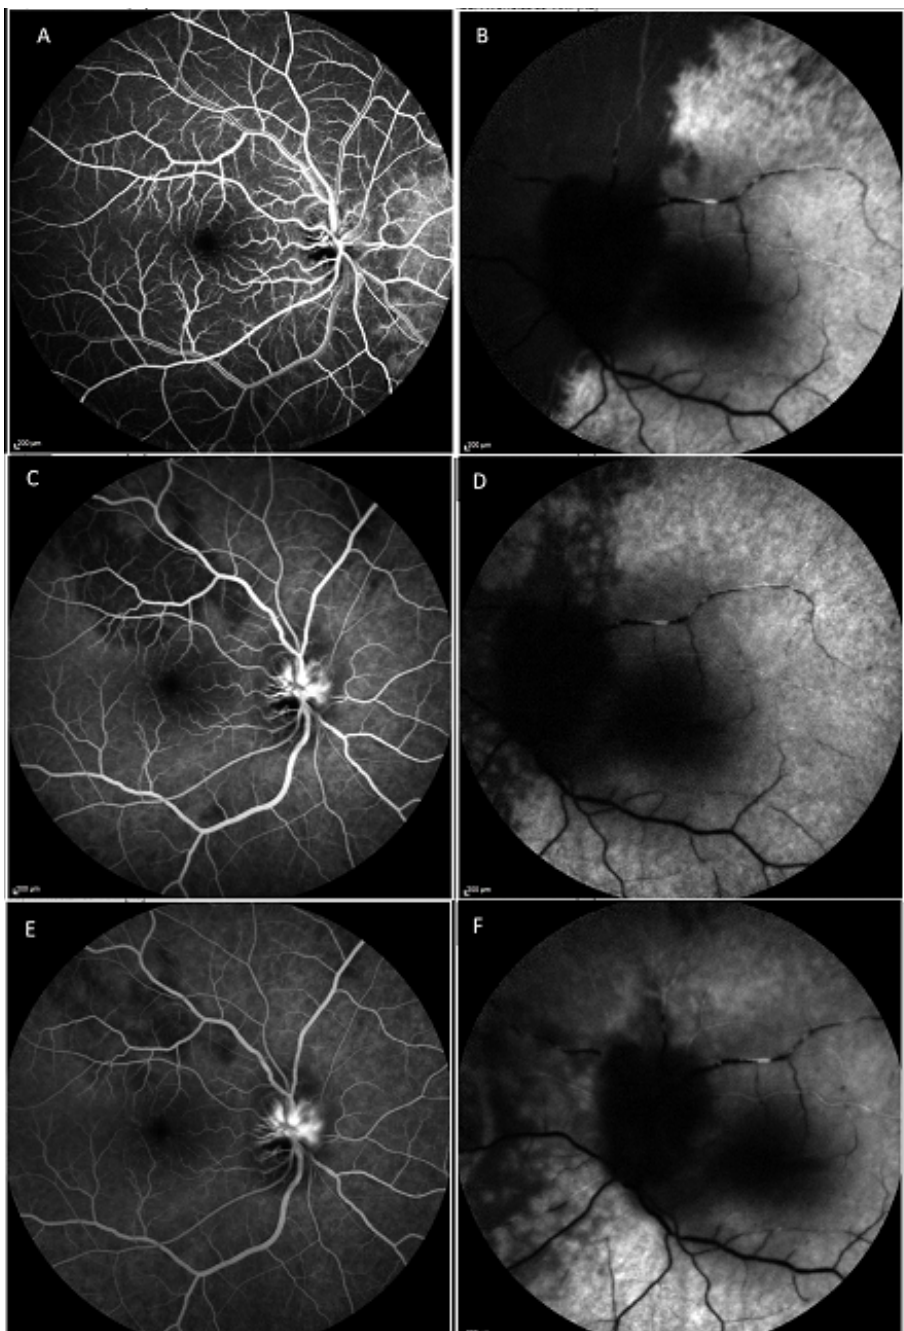
Figure 2. Fluorescein angiography in the early arteriovenous phase (30 sec) reveals a diffuse choroidal filling delay in the right eye (A), and a choroidal filling defect in the nasal retina as well as arterial filling delay in the left eye (B). Fluorescein angiography in the venous phase (1 min), patchy choroidal filling defects accompanied with optic disc leakage in the right eye (C), and a sectoral choroidal filling defect in the nasal fundus as well as arterial filling delay in the left eye (D). Fluorescein angiography in the late phase (5 min) shows patchy choroidal filling defect and optic nerve head leakage in the right eye (E), and patchy choroidal filling defect and arterial filling delay in the left eye